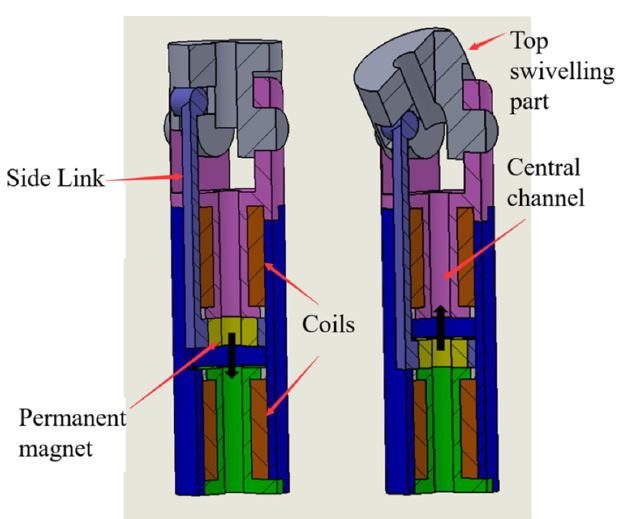
Figure 14. Cross-section views of the new actuator in its straight ( left ) and bending ( right )